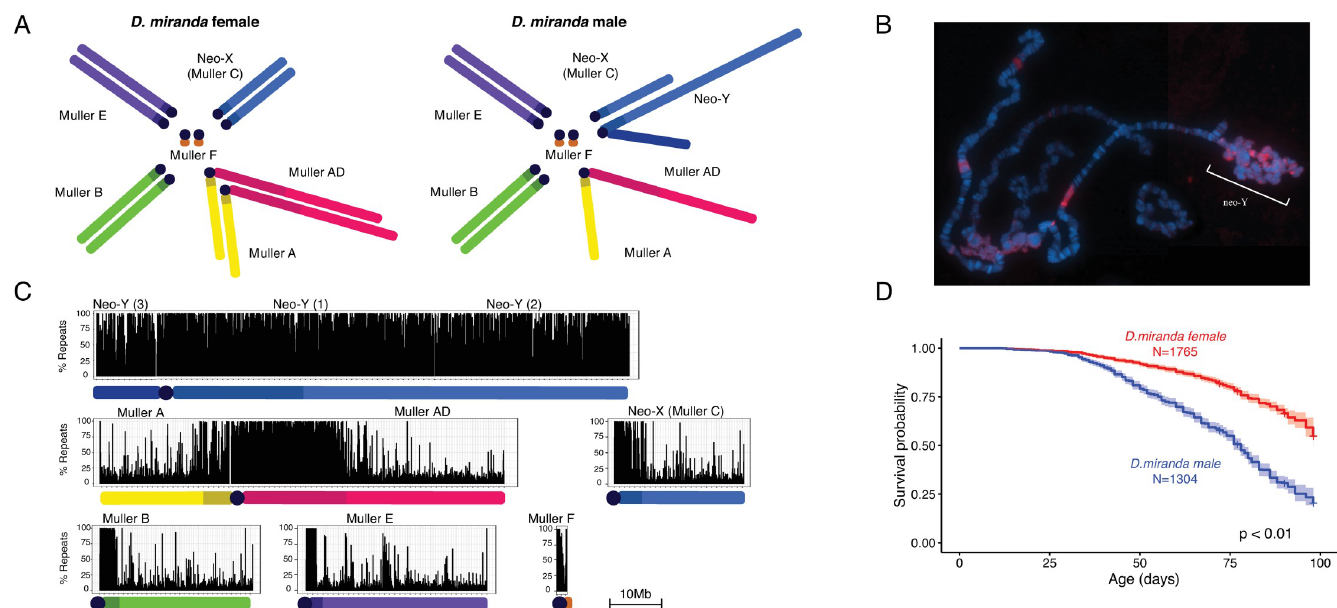
Fig 1. Drosophila miranda karyotype and lifespan. A. Karyotype of D . miranda males and females. Chromosome arms (Muller elements) are color-coded. B. Polytene chromosome squash of D . miranda male stained with HP1 (magenta) marking heterochromatin. C. Genome-wide repetitive content per chromosome. Shown is repeat content (% repeat masked bp) in 50kb windows. D. Kaplan-Meier survivorship curves [72] for MSH22 males (blue) and females (red), with the shaded region indicating the upper and lower 95% confidence interval calculated from the Kaplan-Meier curves. The number of flies counted for each sex (n) to obtain the survivorship curves is